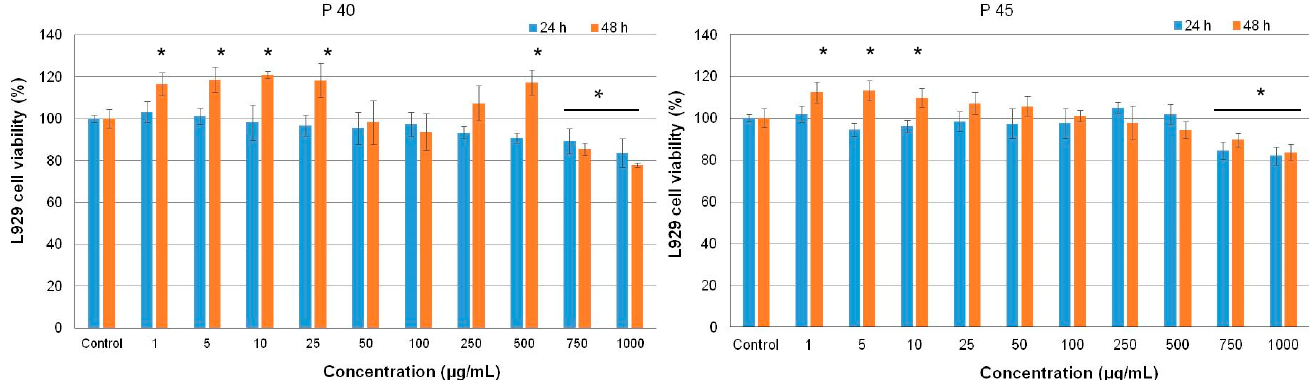
Figure 5. Cell viability of L929 cells cultivated in the presence of different concentrations of S40 and S45 microencapsulated materials, for 24 h and 48 h, determined by NR assay. The results were expressed as mean ± SD ( n = 3). * p < 0.05, compared to untreated control.